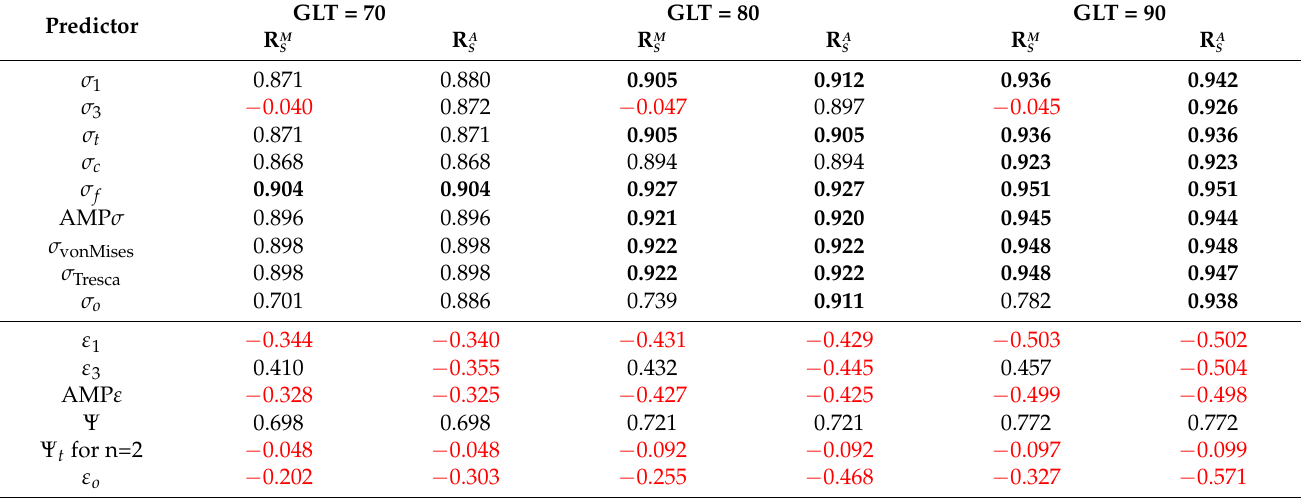
Table 1. Weighted Spearman correlation coefficients obtained with the constitutive model, AnisoH , using C3D4 elements and for different values of GLT: for the maximum variable throughout the cycle, R M , and for the amplitude throughout the cycle, R A . The predictors analysed are: the maximum S S principal stress ( σ 1 ), the minimum principal stress ( σ 3 ), the absolute maximum principal stress (AMP σ ), the corresponding strains ( ε 1 , ε 3 and AMP ε ), the strain energy density (SED or mechanical stimulus at the continuum level Ψ ), the mechanical stimulus at the tissue level ( Ψ t ), the maximum tensile and compressive stresses ( σ t and σ c , respectively), the fluctuation of stresses ( σ f ), the von Mises and Tresca stresses, the hydrostatic stress ( σ o ) and the volumetric strain ( ε o ). Values higher than 0.9 are highlighted in boldface; negative values are in